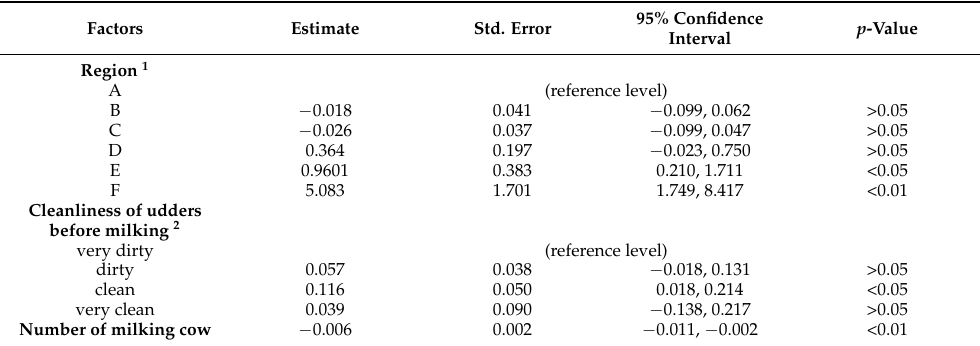
Table 7. Variables in the final multiple linear regression model for the prevalence of clinical mastitis in Kunming dairy